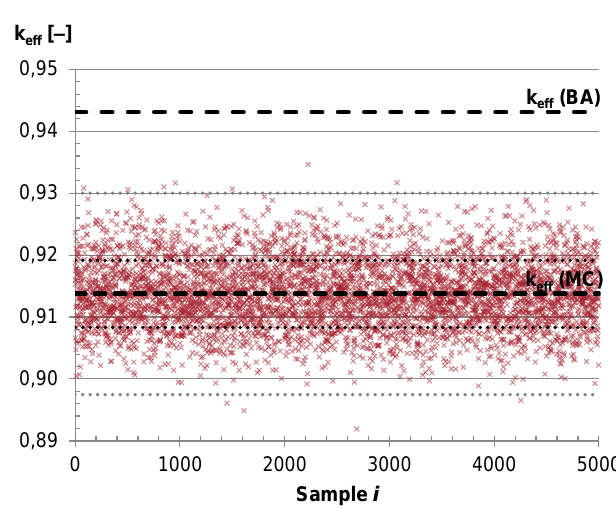
Fig. 5. Comparison of results calculated by bounding approach – k eff (BA), and Monte Carlo sampling – k eff (MC), with its standard deviation represented by dotted line. Results of individual samples k i are also shown (represented by red